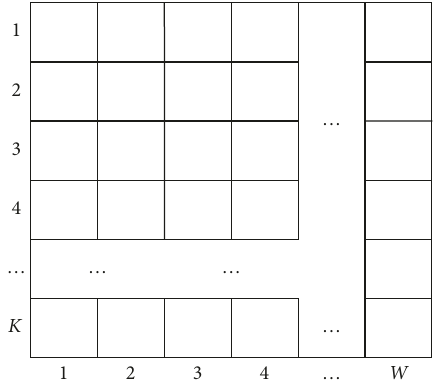
Figure 1: Schematic diagram of the available period of lot